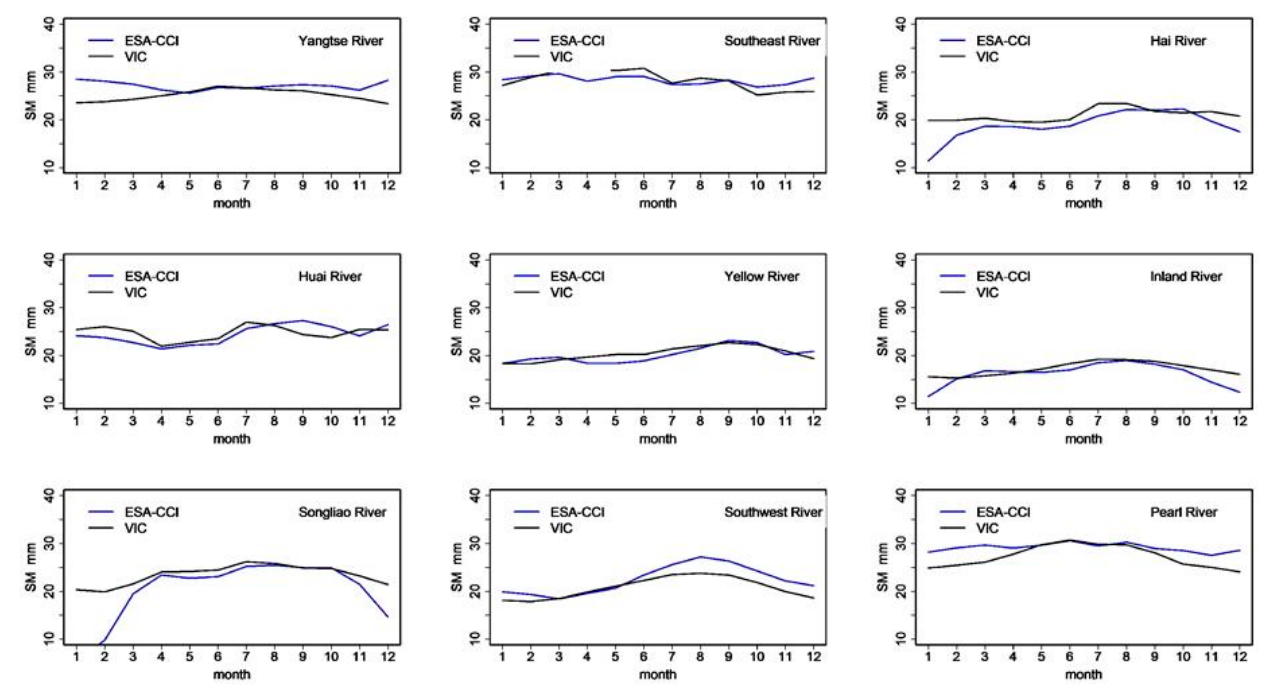
Figure 8. Comparisons of mean monthly SM between the simulations and the ESA-CCI retrieval for the 0–10 cm soil layer over the nine basins.